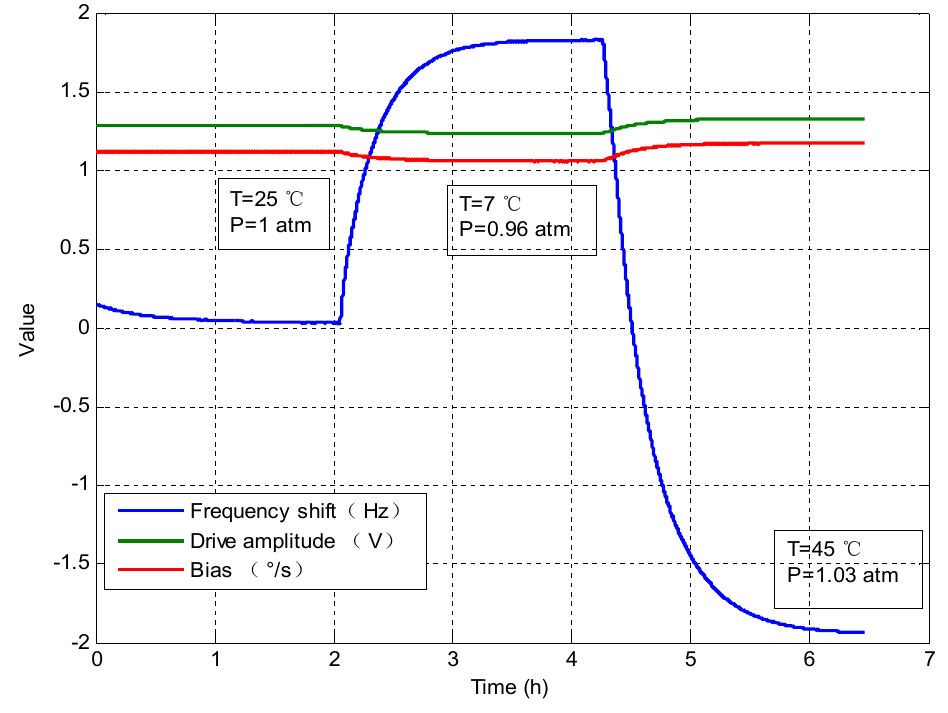
Figure 7. Dual e ff ects on the gyro bias.